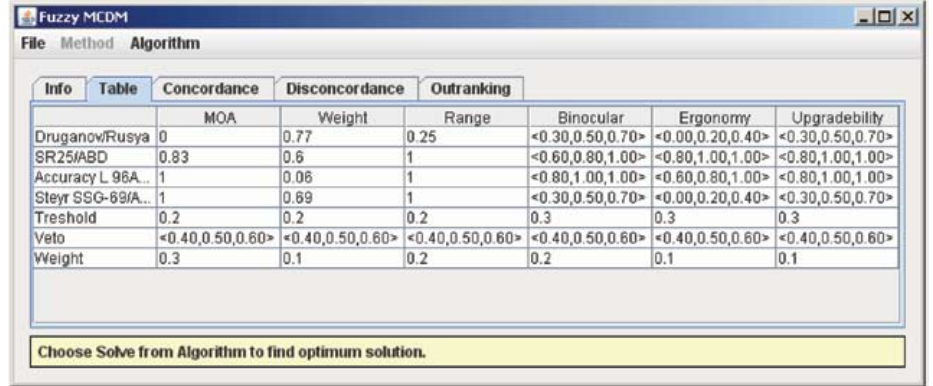
Fig. 5. Outranking-based method applied to the sniper gun selection